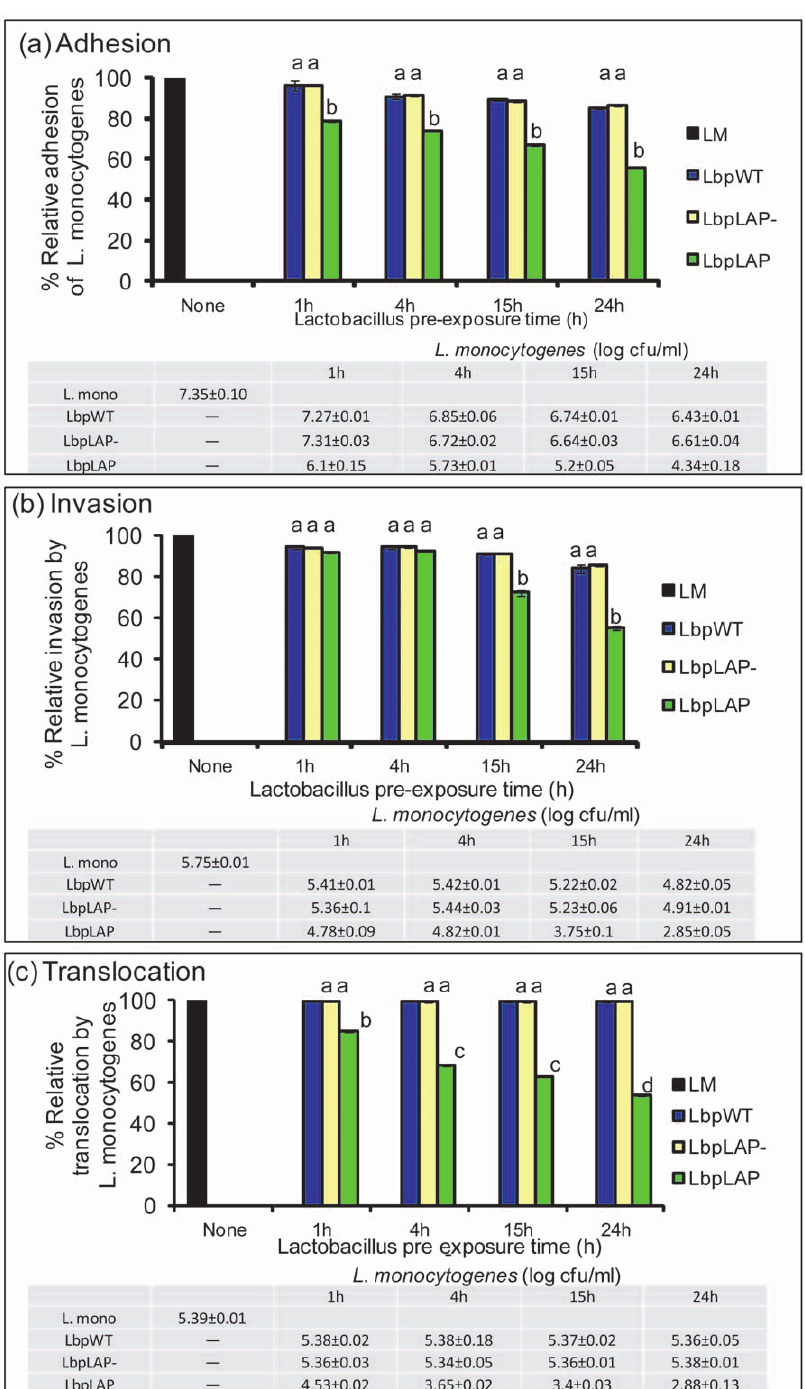
Figure 6. Inhibition of Listeriamonocytogenes (Lm) adhesion, invasion, and transepithelial translocation by recombinant Lactobacillus paracasei (Lbp LAP ). Caco-2 cells were exposed to Lbp LAP , Lbp LAP- (vector without LAP insert) or wild type (Lbp WT ) for 1, 4, 15, and 24 h before infection with Lm for 1 h in (a) adhesion and (b) invasion experiments, and 2 h for (c) transepithelial translocation experiments. Data are averages of three experiments run in triplicate. Bars marked with letters (a, b, c, d) are significantly different at P , 0.05. Table below each graph shows average log Lm counts (SD) for each treatment.